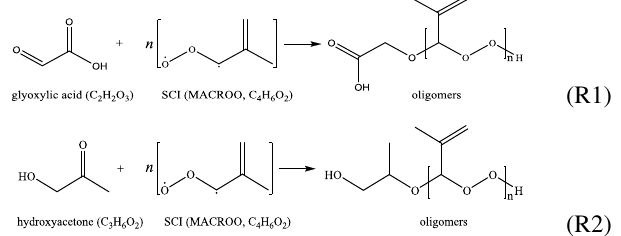
crease in SOA yield from isoprene-NO 2 irradiations. In